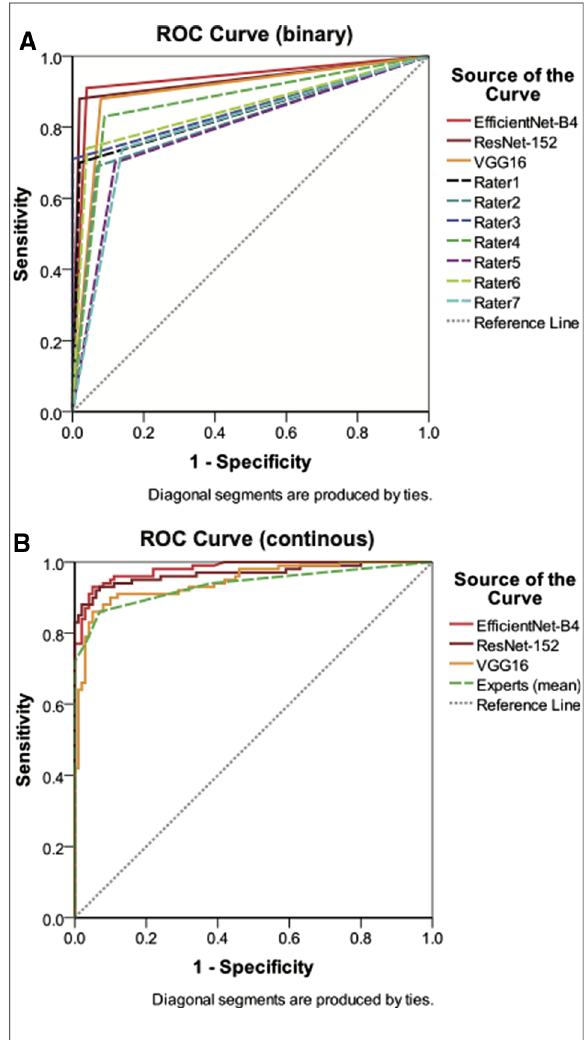
FIGURE 4 Binary ( A ) and continuous ( B ) data ROC analysis of diagnostic performance for CNN models and human experts in the test dataset ( n =200).